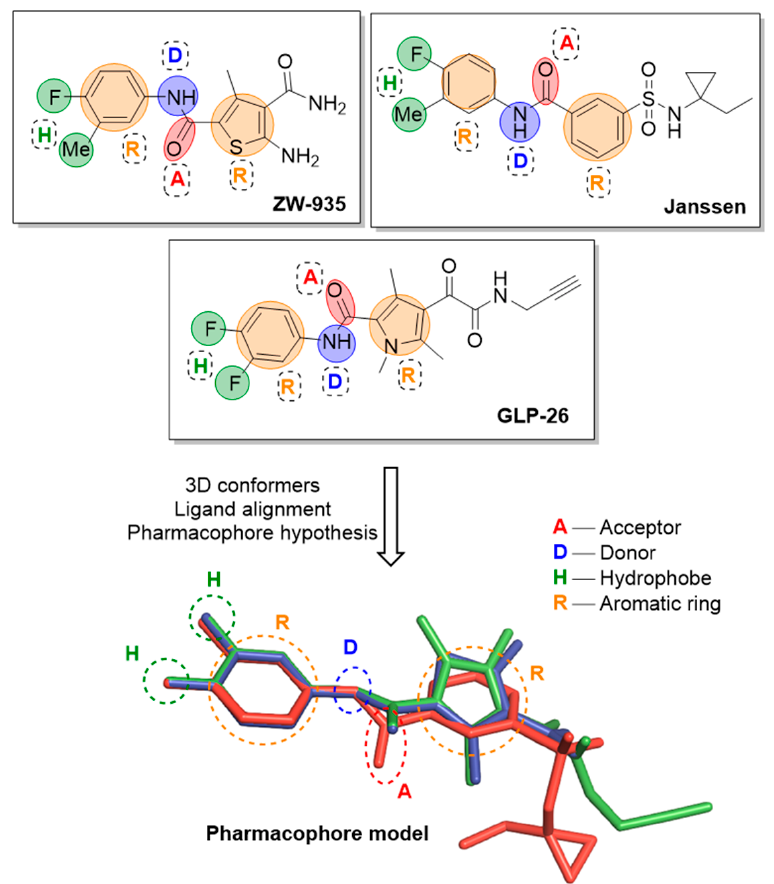
Figure 4. Pharmacophore model generated using ZW-935, Janssen, and GLP-26 as active ligands. Acceptor, donor, hydrophobe, and aromatic ring features are denoted by A, D, H, and R, respectively. Ligand alignment between ZW-935, Janssen, and GLP-26 are shown in green, red, and blue sticks, respectively ( bottom ).